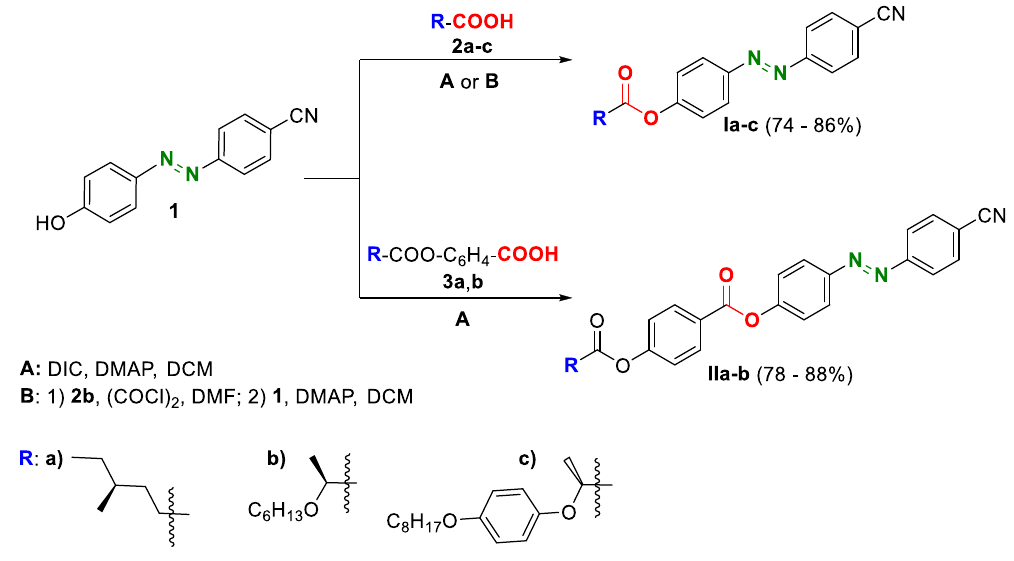
Figure 2. Synthesis of the target materials Ia-c and IIa-b . Two synthetic methods, A and B, were used. Chiral units, R, are marked in blue and depicted at the bottom of the figure.